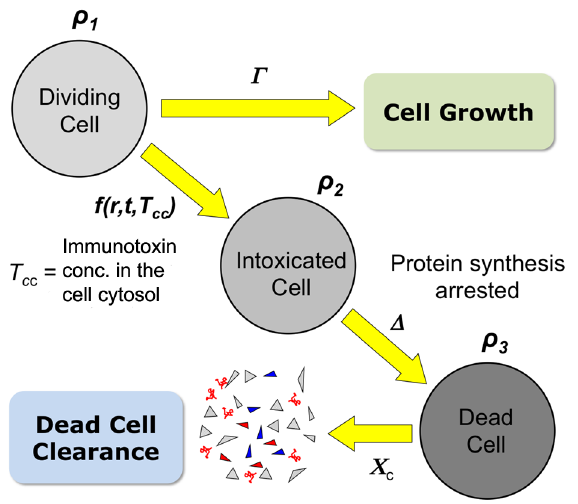
Figure 7. Kinetics of tumor cell population changes. The model defines three different tumor cell types: un-intoxicated, intoxicated, and dead cells, with densities r 1 , r 2 , and r 3 , respectively. The un-intoxicated cells proliferate, but the intoxicated and dead cells do not. The conversion from un-intoxicated to dead cells is irreversible. The number of the surface antigen molecules on an un-intoxicated cell remains constant, but it decays on an intoxicated cell through endocytosis and shedding without supply of newly synthesized internal antigen. Both protein synthesis and endocytosis have stopped in the dead cell, but the shedding and the on and off reaction between the surface antigen and immunotoxin still go on. The dead cells are removed from the tissue, presumably by macrophages, at a certain rate.